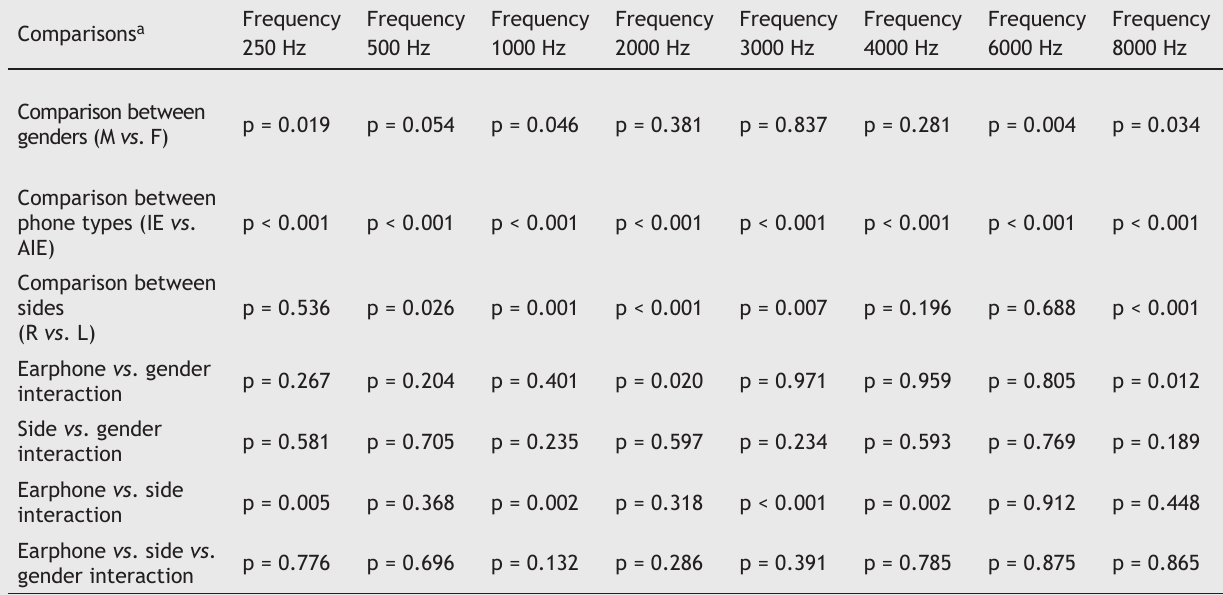
Figure 6 Peak intensity in each earphone. F, female; M, male; RE, right ear; LE, left ear; IP, intensity peak; IE, insertion earphone; AIE, anatomic insertion Table 1 ANOVA results for repeated measures for comparison (sound pressure level between headphones, sides, and genders) consi- dering the tested frequencies.